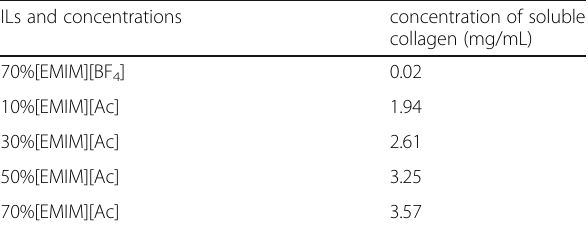
Table 1 The concentration of soluble collagen in different ILs and concentrations